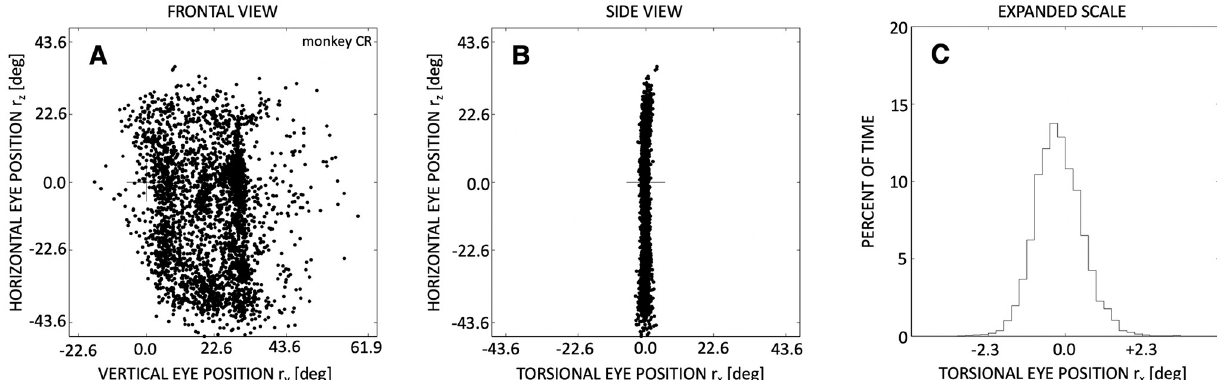
Fig 3. Listing’s law for ± 3500 eye positions during spontaneous saccades in the light, of a monkey. All eye orientations lie in a well-defined plane, which is perpendicular to the torsional direction, and defines the primary position (cross at (0,0,0)). The center of the oculomotor range is, for this animal, about 20 deg down from primary position, and the animal’s head was pitched downward by 15 deg. (A) Frontal view of LP. (B) Side view of LP. (C) Expanded side view of LP. After: [18].